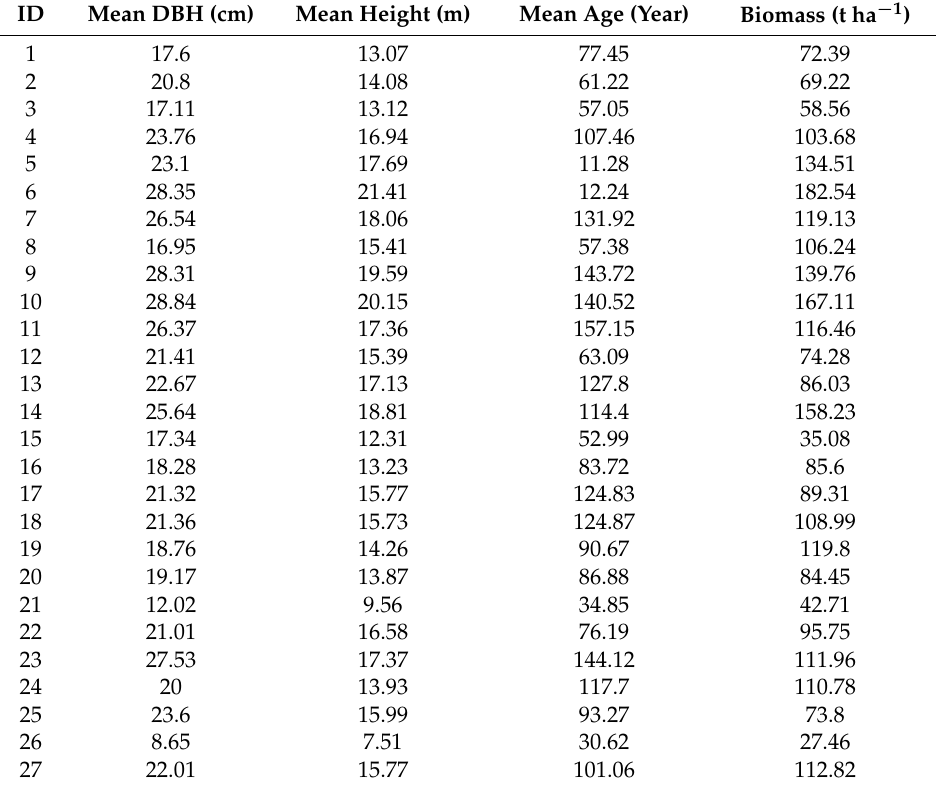
Table 1. Main features of the in-situ